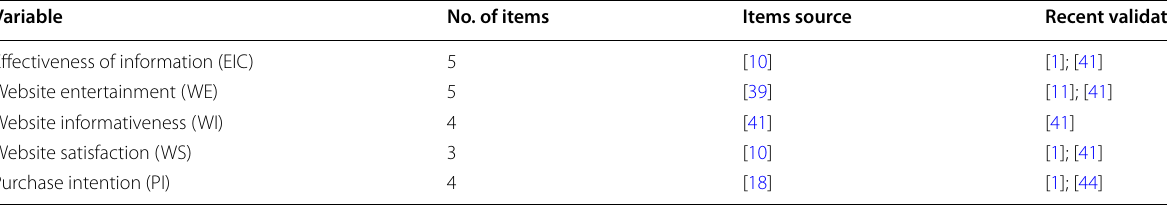
Table 1 Variables, number of items, and latest validation sources Variable No. of items Items source Recent